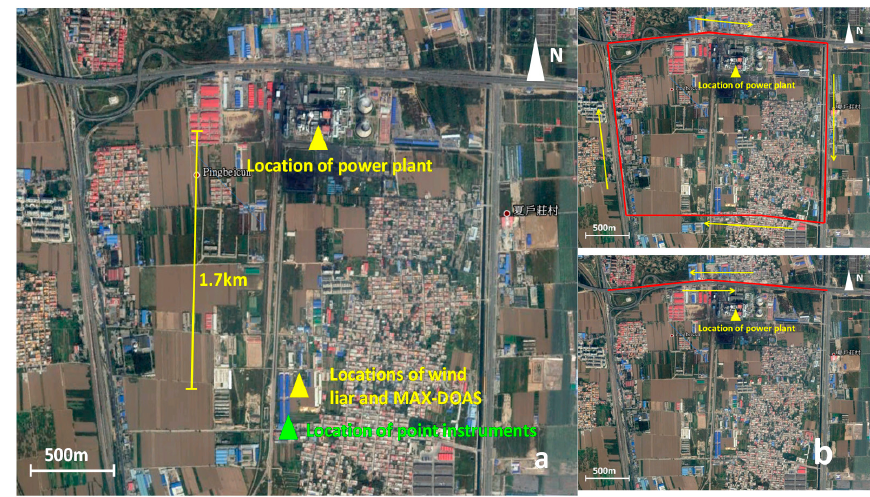
Figure 1. Setup of measurement sites ( a ) and two different driving routes ( b ). Red lines indicate the measurement routes and yellow arrows indicate the driving direction in the ( b ).